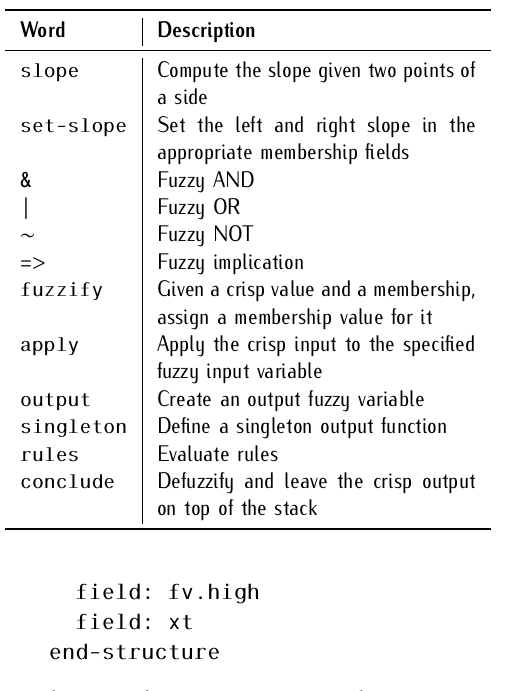
Table 1. Words defined in the dictionary to implement fuzzy reasoning according to